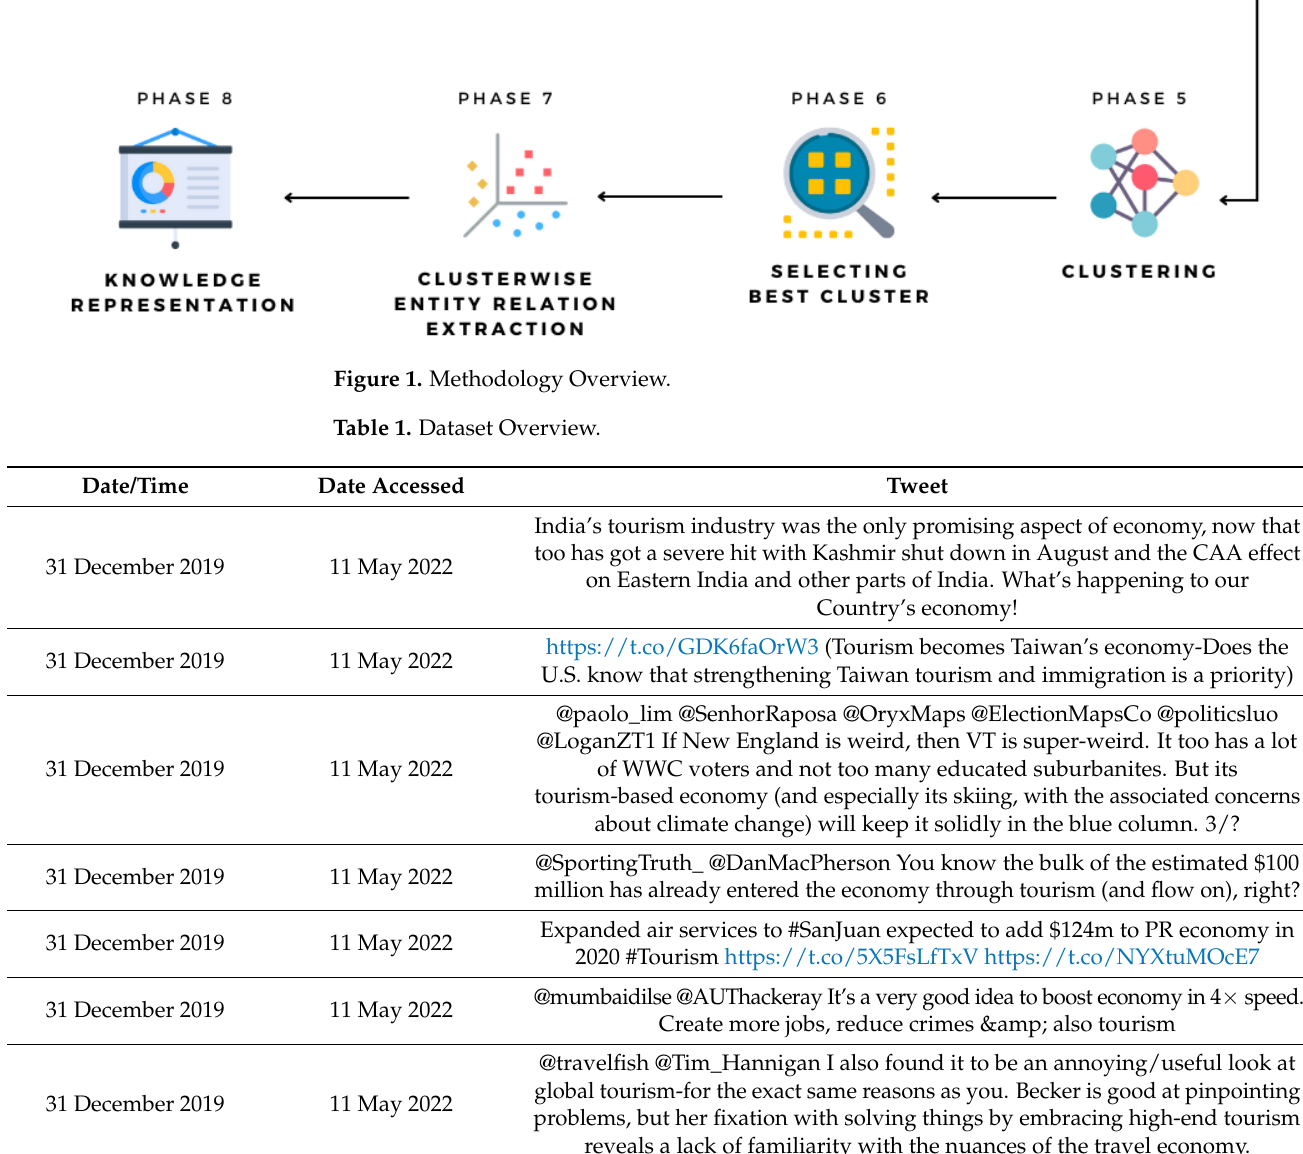
Table 1. Dataset Overview.